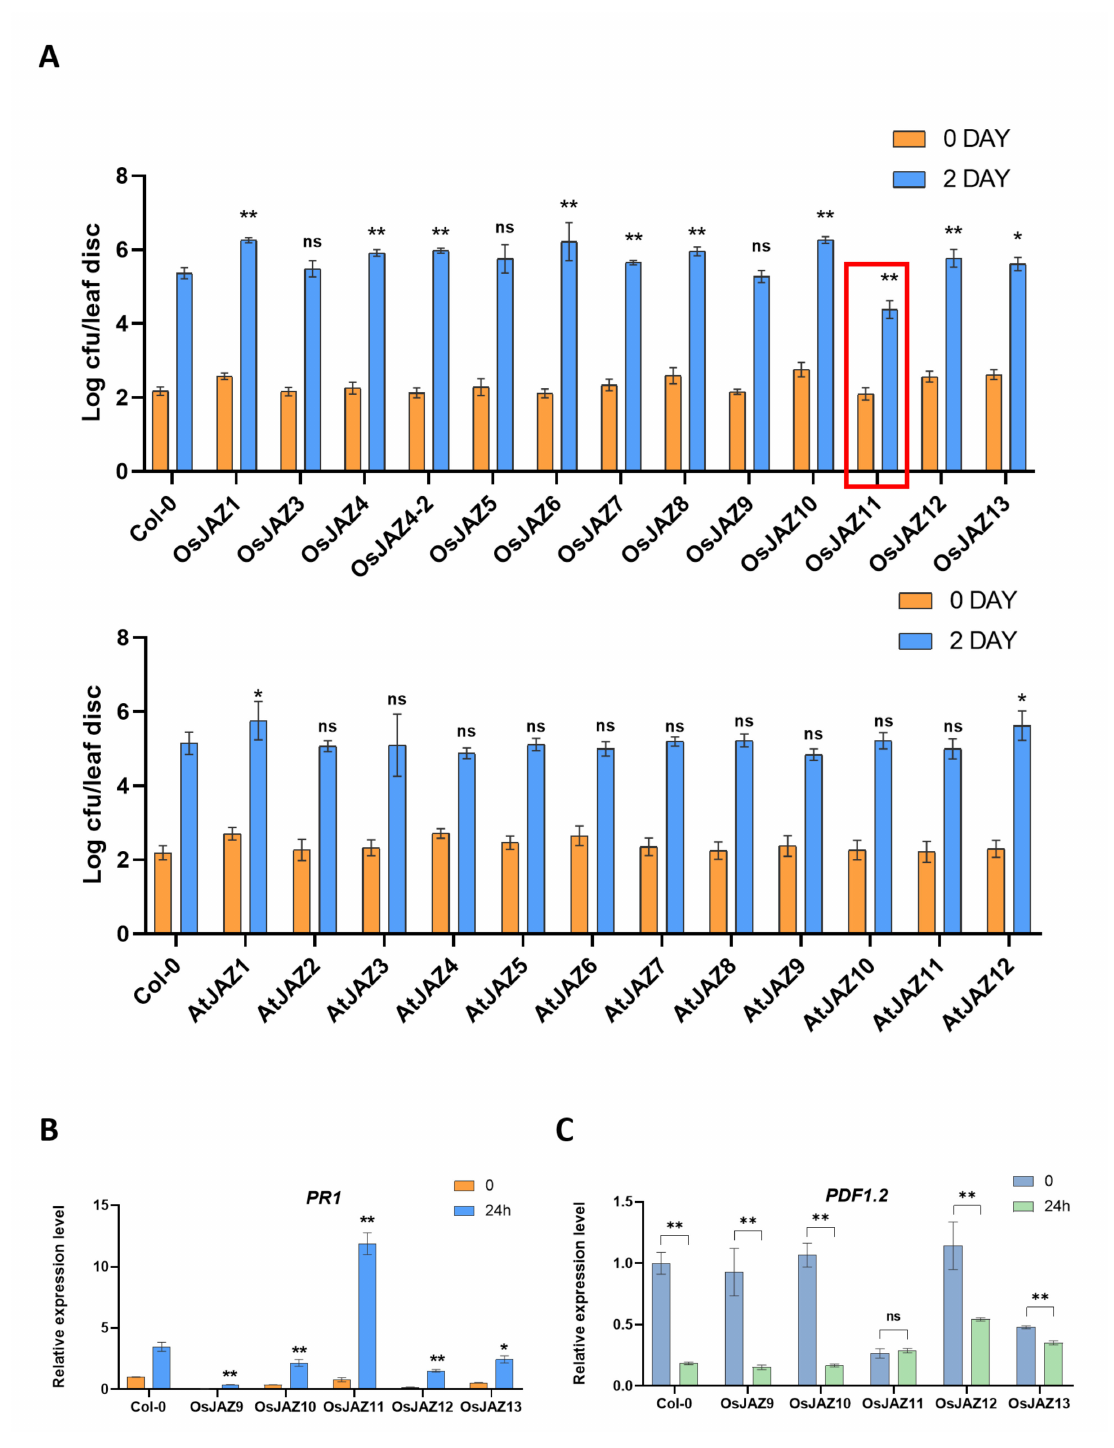
Figure 3. Overexpression of OsJAZ11 enhances plant resistance to Pst DC3000. ( A ) Three- to four- week-old plants were infiltrated with Pst DC3000 bacteria (1 × 10 4 CFU · mL − 1 ) via a syringe, and the bacterial population in the leaves was quantified on day 0 to confirm uniform inoculation and again two days after inoculation. The results in the graphs are the means of two independent experiments ( n = 8 to 12) ± SEs (*, p < 0.05; **, p < 0.01; ns, no significance; Student’s t -test). CFU = colony forming unit. ( B , C ) Relative transcript levels of PR1 and PDF1.2 in different lines before and after inoculation. The data shown are the means ± SEs ( n = 3) (*, p < 0.05; **, p < 0.01; ns, no significance; Student’s t